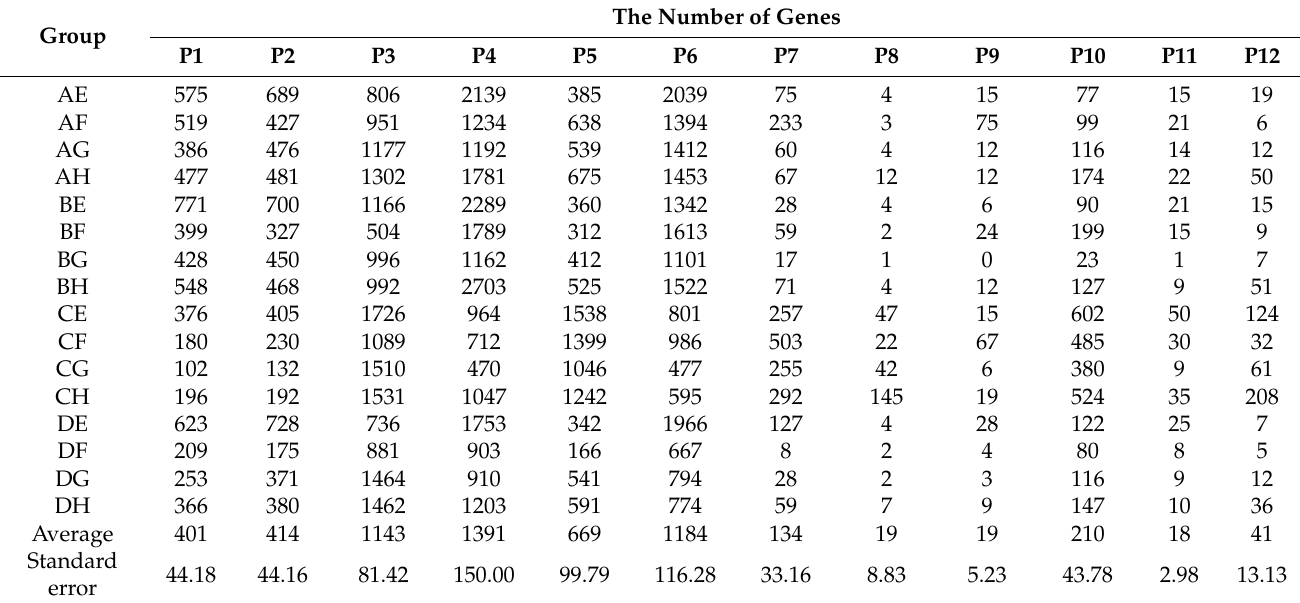
Table 2. A number of genes in each of the 12 expression patterns of differentially expressed